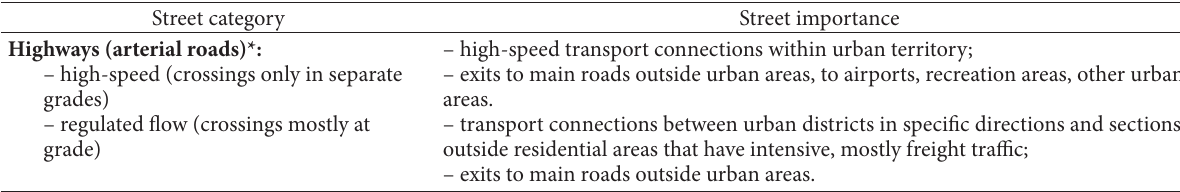
Table 1. Street categories and their basic importance specified in the norms ( LBN 100 ; СниП 1989